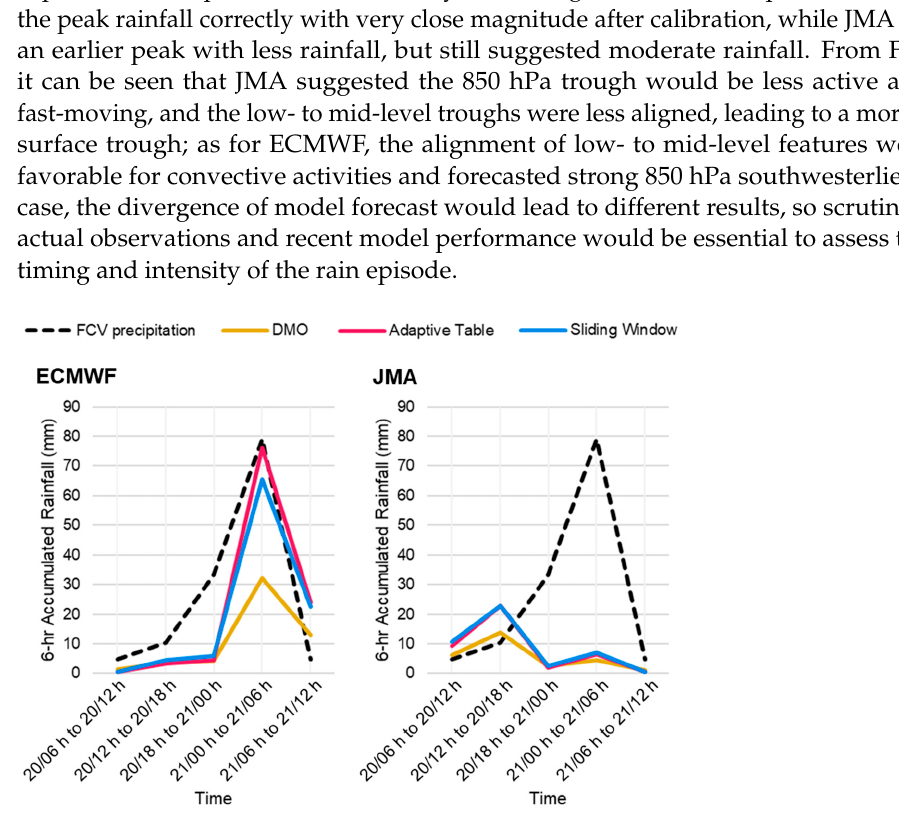
Figure 20. ( a , b ) The predicted 850 hPa moisture and wind fields of ( a ) ECMWF, ( b ) JMA for 20 May 2016 18 Z. ( c ) Ground truth of the same time based on ECMWF T + 6 h forecast. ECMWF indicated a deeper vortex over Guangdong and stronger southwesterly flow as a result of alignment of features. 5. Conclusions and Further Work Intense rainfall events are often underestimated by global NWP models due to the low skills in convective parametrization and coarse resolution of grids with order of 10 km. This study introduced two frequency-matching methods to calibrate DMO QPFs from ECMWF and JMA against actual 6 h rainfall over Hong Kong. Forecast rainfalls were cal- ibrated through establishing relations between the past forecast and observed rainfall, i.e., the f-t conversion, and the conversion tables would be updated after new observations were available. The Adaptive Table method updates the conversion table whenever the model QPF under- or over-estimates the observed rainfall with certain significance, and the Sliding Window method updates the table with forecasts and observations in the most recent two years, with a sliding time window.